Question: Briefly state, in one sentence, what is plotted here.
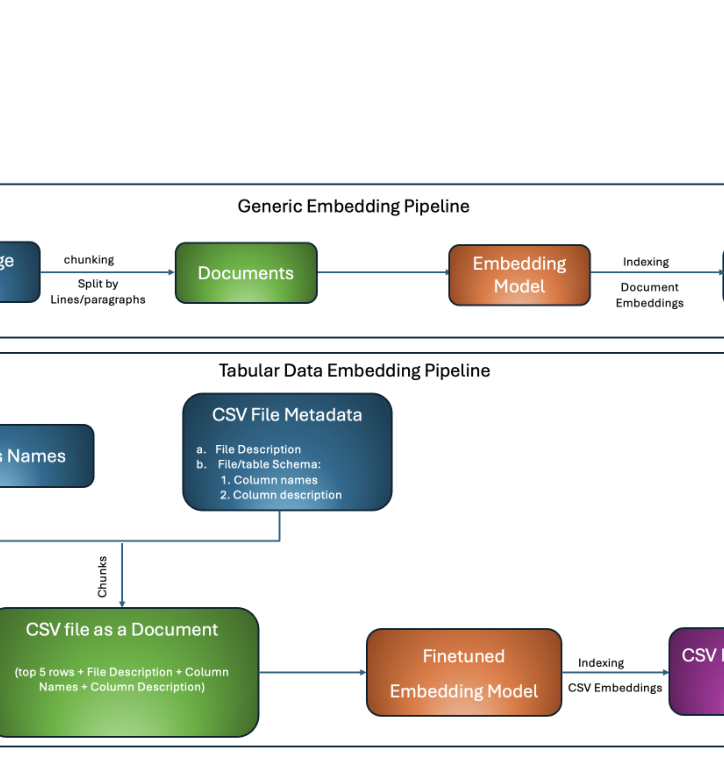
Answer: contrasts the tabular data indexing approach vs generic approach.